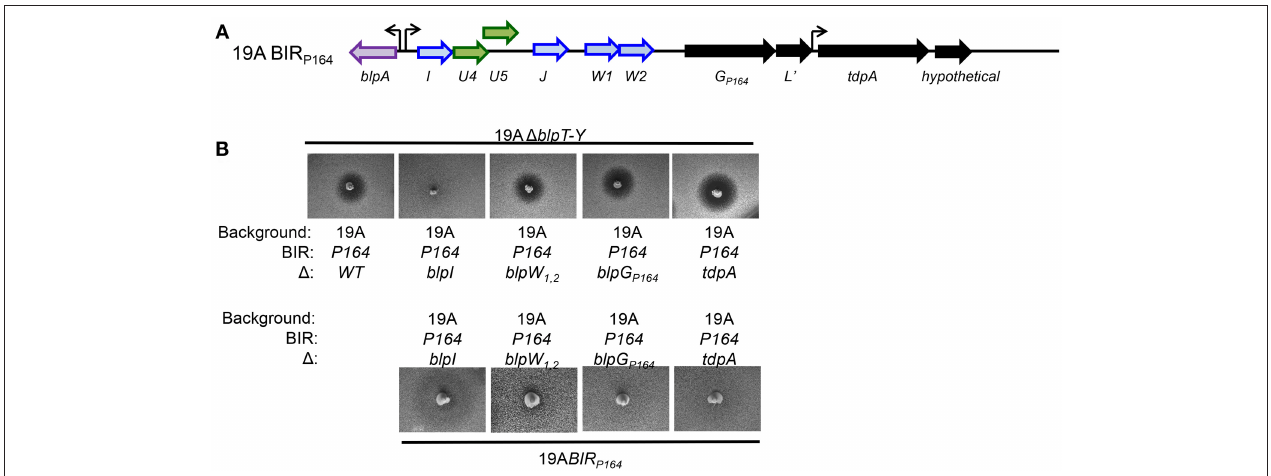
FIGURE 1 | Functional analysis of the BIR region of P164 strain after moving into a 19A strain background. (A) Schematic representation of BIR P164 . Blue arrows indicate predicted pneumocins, and green arrows indicate predicated immunity proteins. Black arrows indicate ORF encoding proteins of unclear significance. Curved arrows represent predicted transcriptional start sites based on the presence of a predicted BlpR binding site. (B) Agar overlay assays showing inhibitory and immune phenotypes. The properties of strains spiked into the plate are shown below the photo, overlay strains designations are shown above the photo.